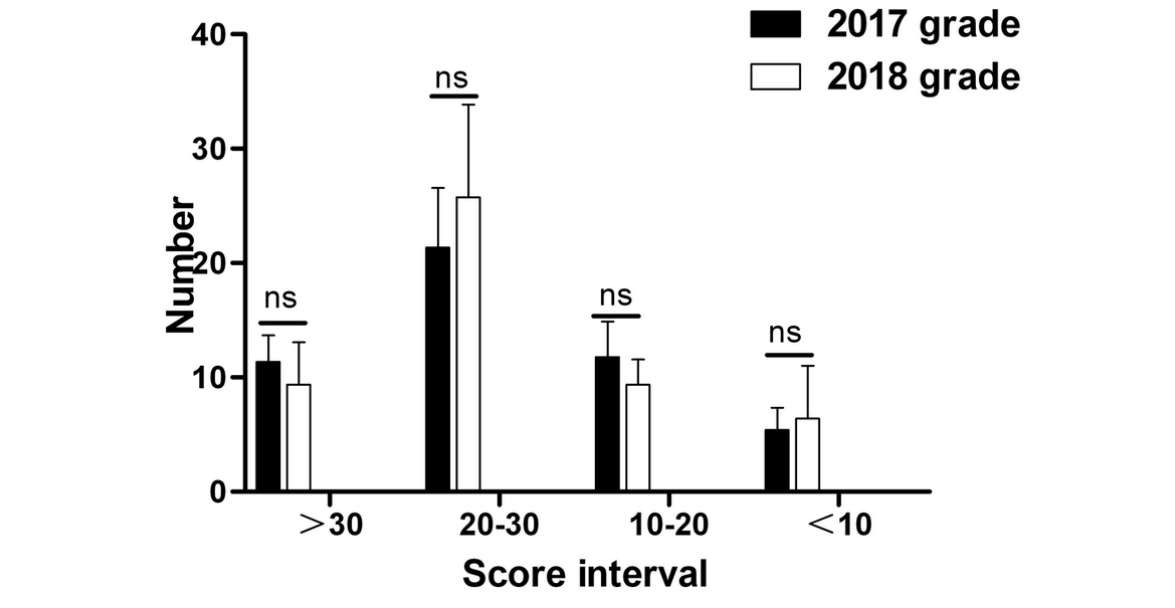
Figure 13. Statistical differences in the different score intervals for subjective scores in the final written pathology examination results. *: statistical significance; ns: no statistically significant